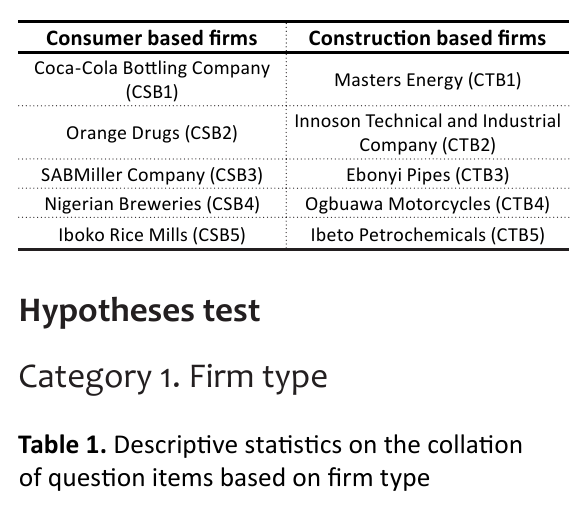
Table 1. Descriptive statistics on the collation